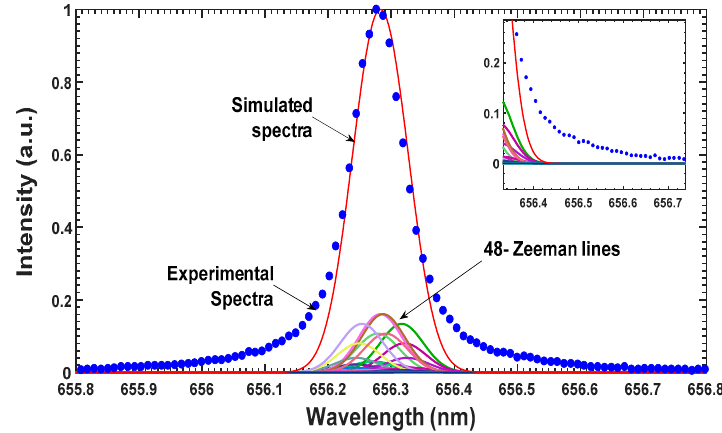
Figure 4. Fitting of the H α experimental spectrum with simulated spectra by considering all 48 Zeeman lines and the hydrogen atom having a single temperature.